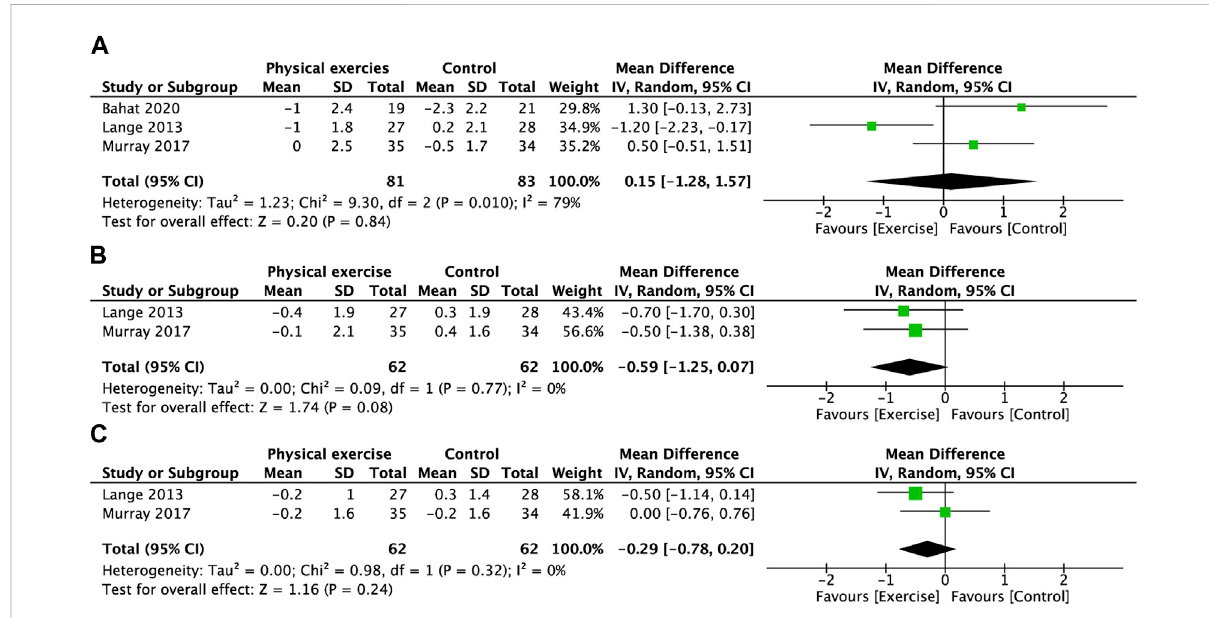
FIGURE 8 ForestplotcomparingtheVASscoresoftheneckandshoulderinthephysical exerciseandcontrolgroups. (A) Neck. (B) Rightshoulder. (C) Left shoulder. VAS, visual analog